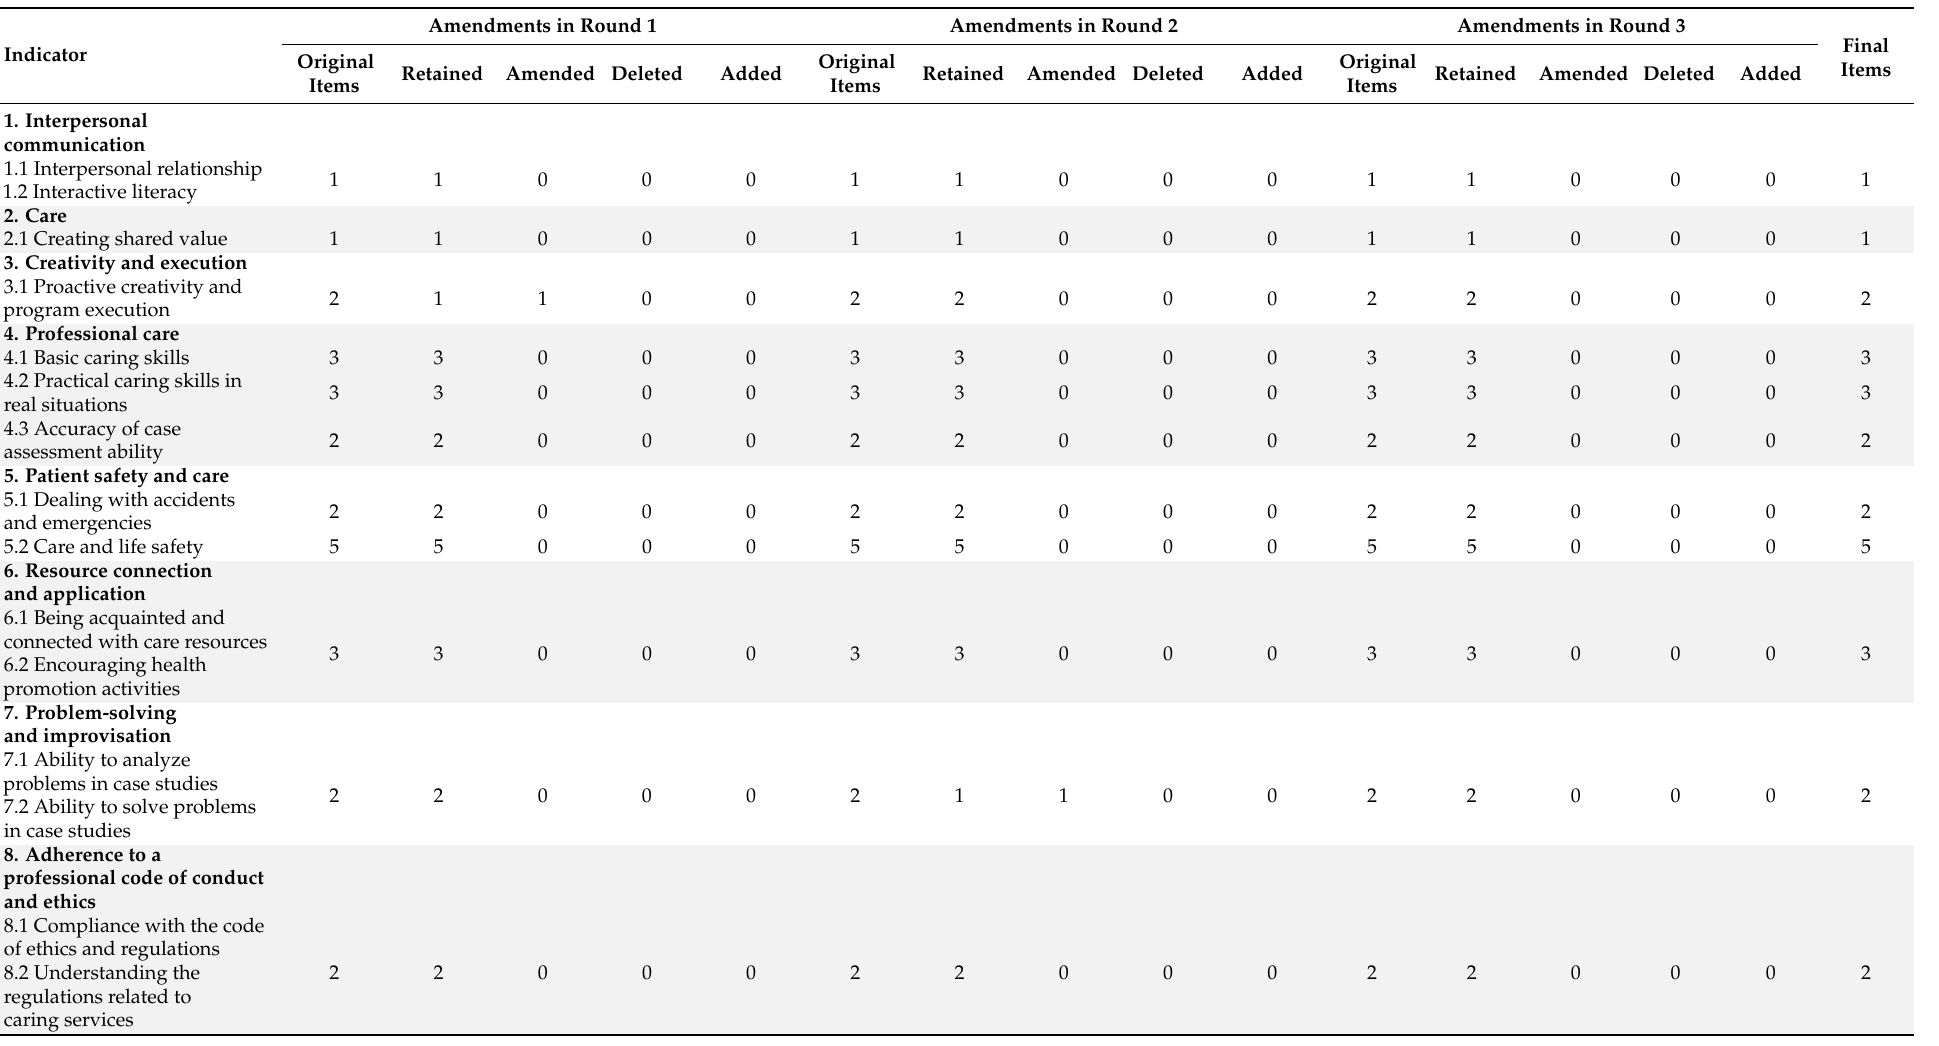
Table 5. Questionnaire amendments of the professional curriculum in the three-round Delphi questionnaire survey ( n =